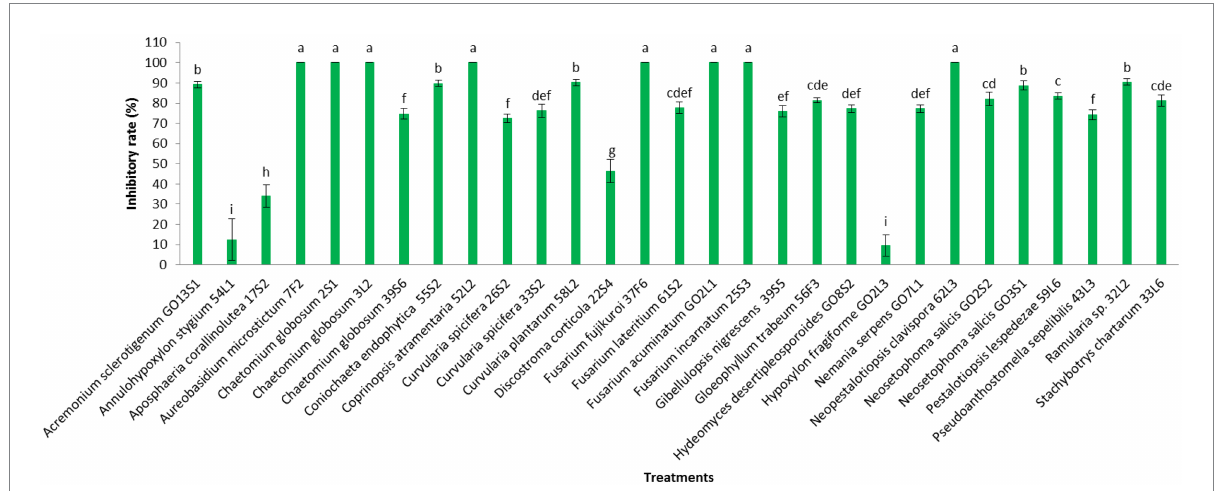
FIGURE 9 Effect of volatile organic compounds of endophytic fungi isolated from apple on Venturia inaequalis mycelia growth after 1 month in vitro . Data are the means ± SE of three replicates. Values of histograms with common letters are not significantly different at p ≤ 0.01 according to Duncan’s multiple range test.